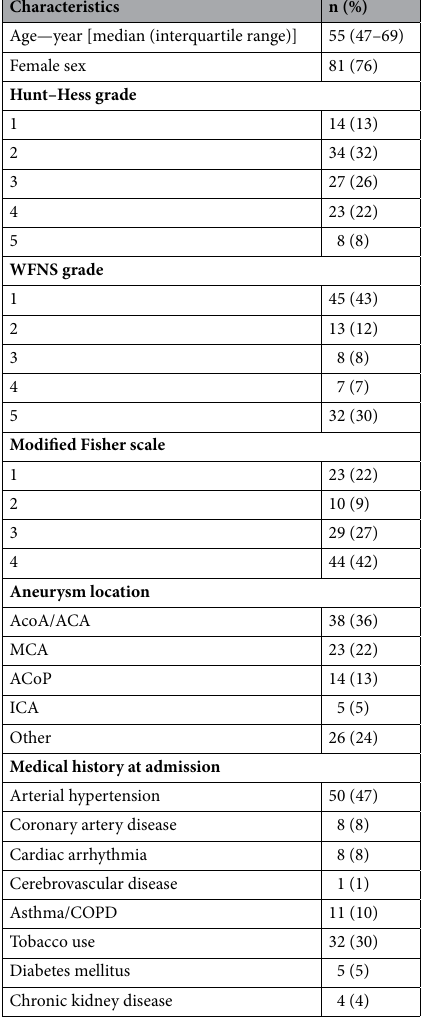
Table 1. Patient characteristics at admission. WFNS World Federation of Neurosurgeons, ACoA Arteria communicans anterior, ACA Arteria cerebri anterior, MCA Arteria cerebri media, ACoP Arteria communicans posterior, ICA Arteria carotis interna, COPD Chronic obstructive pulmonary